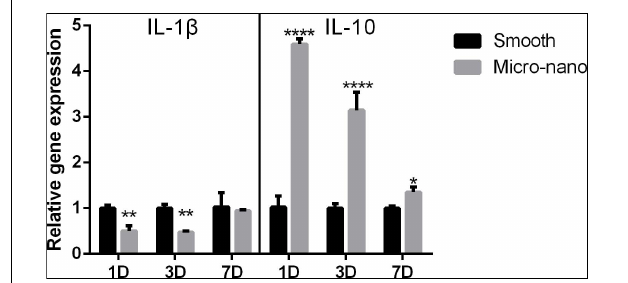
FIGURE 2 | Gene expression of RAW264.7 cells on different titanium disks. (smooth, smooth titanium disk; micro-nano, small-scale topography titanium disk. * p < 0.05, ** p < 0.01, **** p <